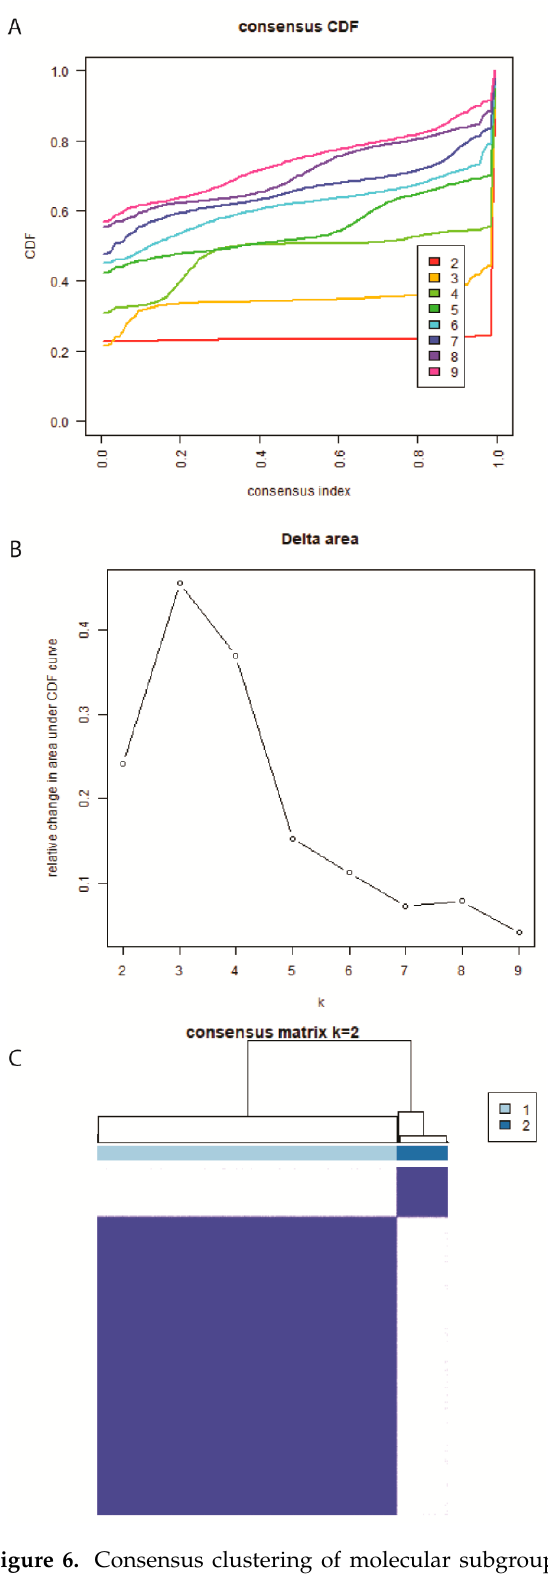
Figure 6. Consensus clustering of molecular subgroups in EC based on hypoxia-related DEGs ( A ) Cumulative distribution function (CDF) curve from k = 2 to k = 9. ( B ) CDF Delta area curve. The horizontal axis represents the number k and the vertical axis represents the relative change in the area under the CDF curve. ( C ) Consensus matrix heatmap of two clusters (k = 2) and the correlation area.